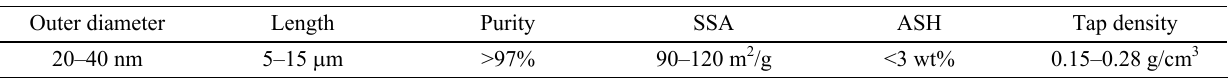
Table 2 Properties of carbon